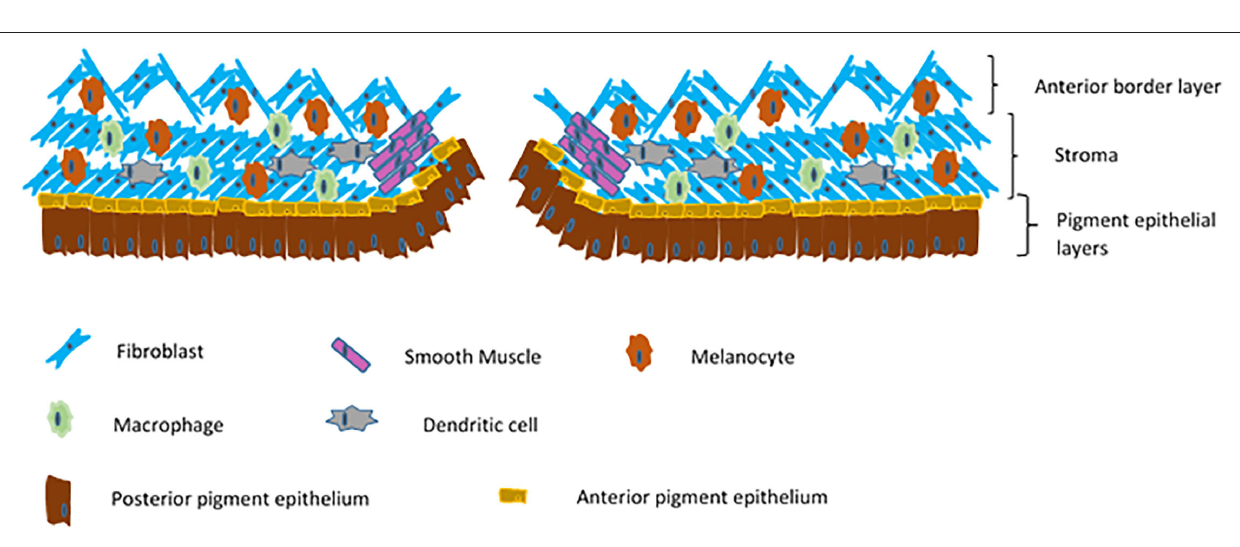
was variable. Macrophages within the rat iris have a slower at least a portion of these cells derive from the